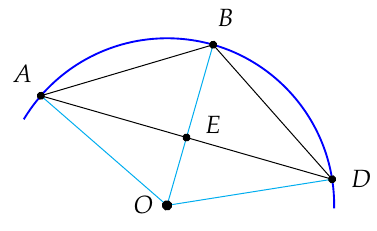
Figure 4. An inscribed isosceles trapezoid.